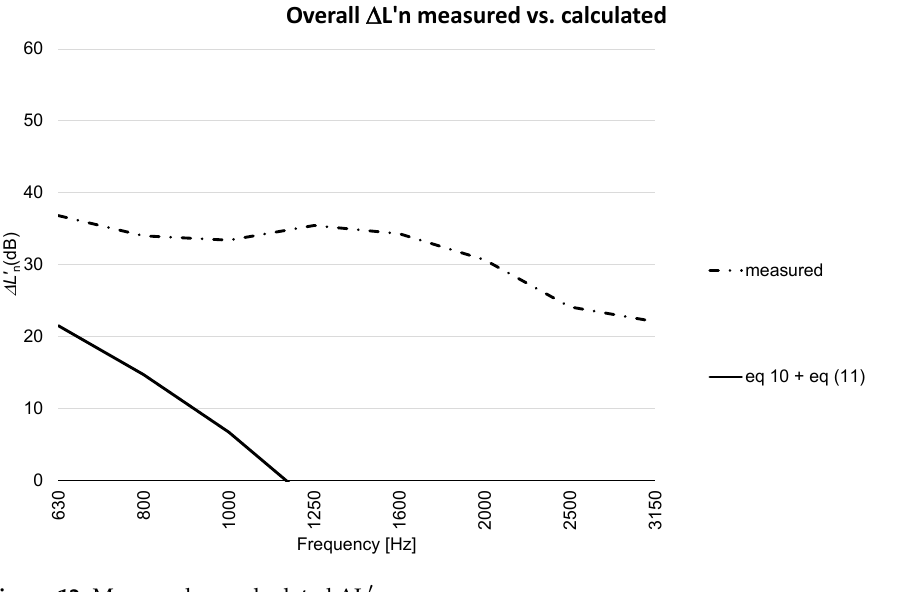
Figure 12. Measured vs. calculated ∆ L (cid:48) n,w The retrieved equation from measured values is reported below, with a regression coefficient of R 2 = 0.81 (Equation (12)).